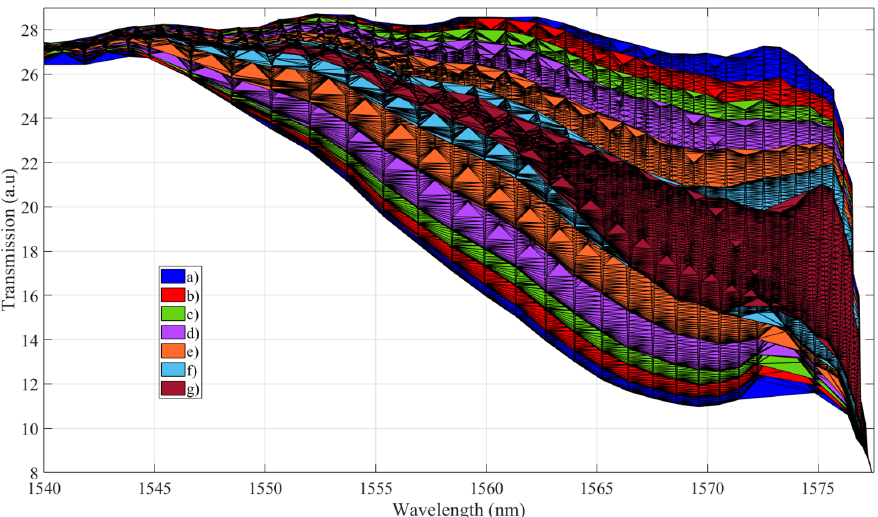
Figure 22. Envelope areas of the cladding modes resonance peaks of the spectra shown in Figure 20 using the D-T demodulation